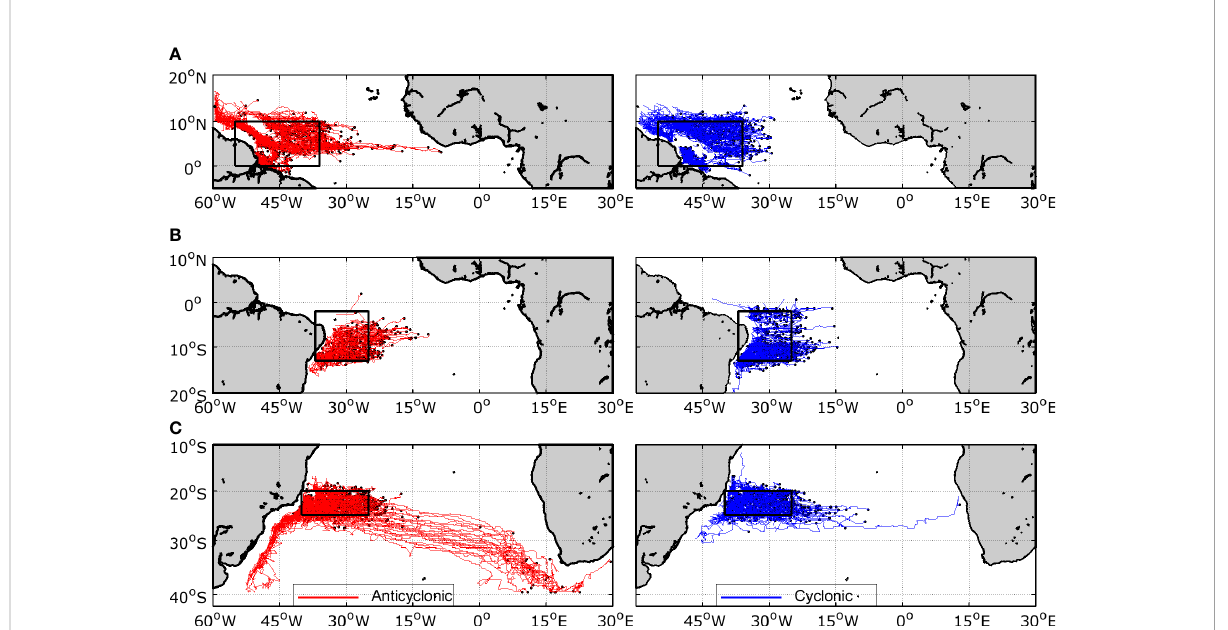
FIGURE 11 Mesoscale eddy trajectories detected in the tropical Atlantic crossing the: (A) Amazon river plume region (55° – 36°W; 0° – 10°N), (B) northeast Brazil region (37° – 25°W; 13° - 2°S) and (C) southwestern tropical Atlantic (40° – 25°W; 25° - 20°S). Red (blue) lines indicate AE (CE) trajectories. Black dots indicate eddy generation